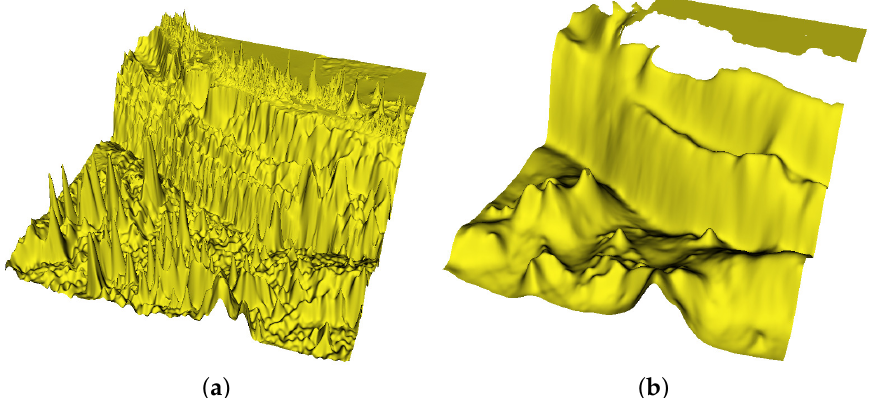
Figure 4. Left ( a ): Bathymetry downloaded from the National Oceanic and Atmospheric Administration (NOAA) website, (min = − 7239 m and max = 3002 m). Right ( b ): smoothed bathymetry with β = 20 in (8) , (min = − 6207 m and max = − 100 m).